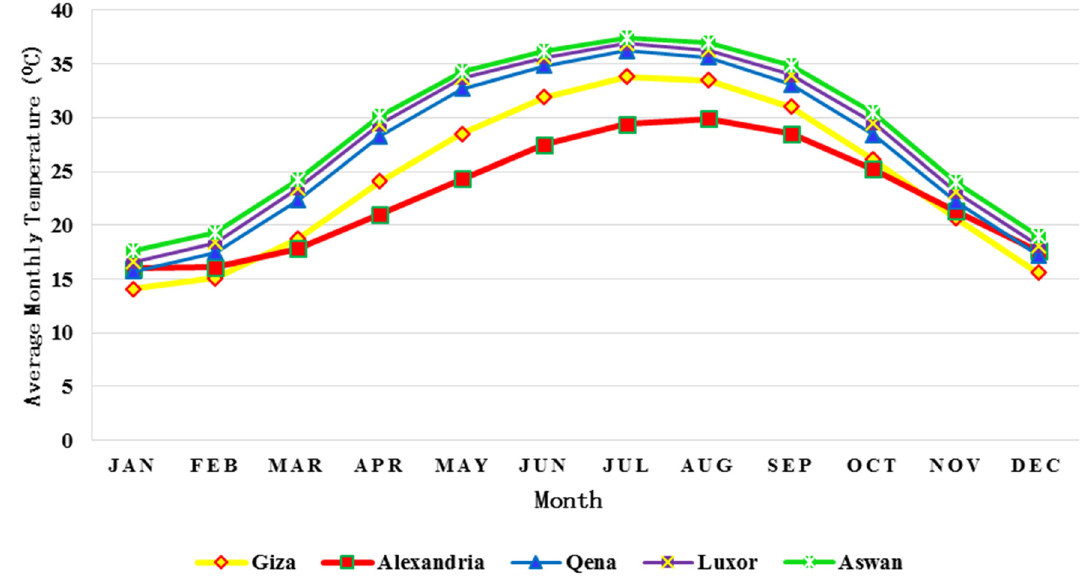
Figure 6. The average monthly earth’s surface temperature in Giza, Alexandria, Qena, Luxor, and